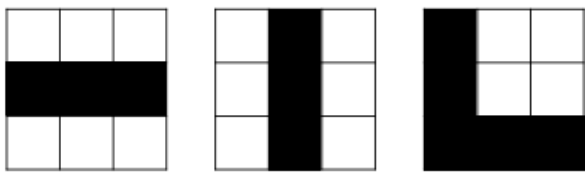
Figure 3. The filter on the left might activate strongest when it encounters a horizontal line; the one in the middle for a vertical line and the right one for ‘L’ shape line.